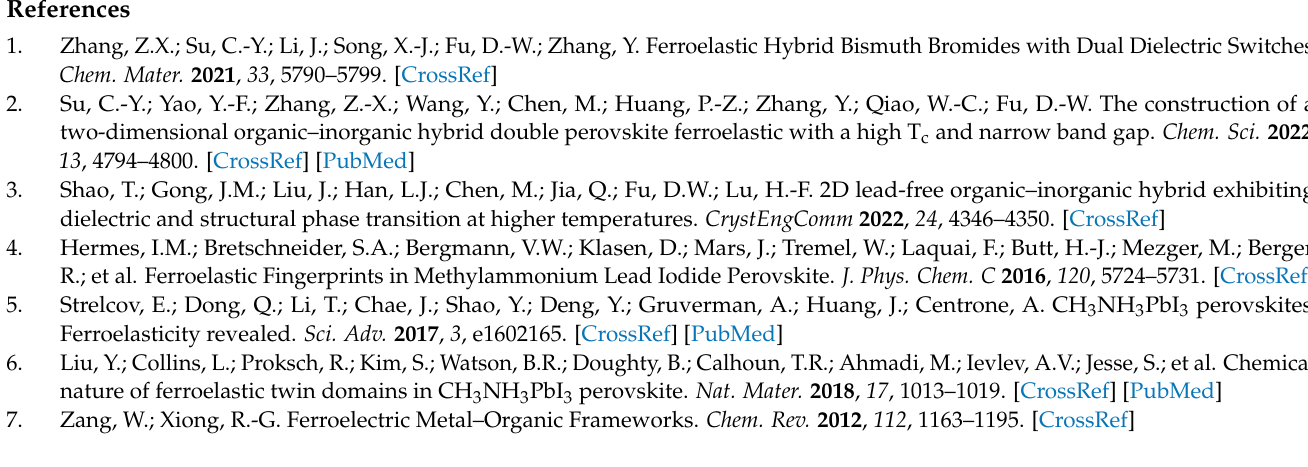
Table S4: Anisotropic displacement parameters (Å 2 × 10 3 ) for Imma_a; Table S5: Hydrogen